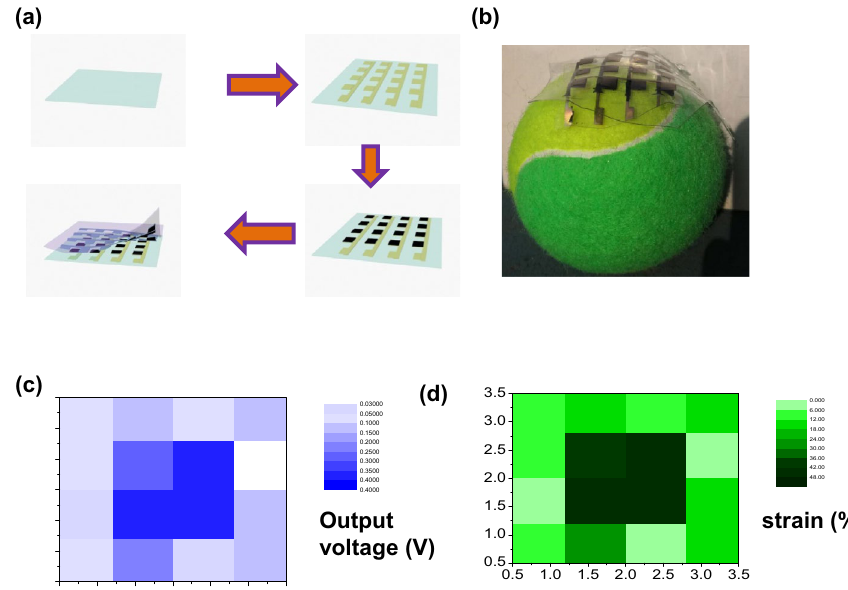
Figure 5. Strain sensing array based on direct-current generators. ( a ) Fabrication process of the array of direct- current generators. ( b ) Photo images of direct-current generator array conformally attached on a tennis ball. ( c ) Mapping of voltage output of every unit in the array. ( d ) Mapping of pressure extracted from the measured